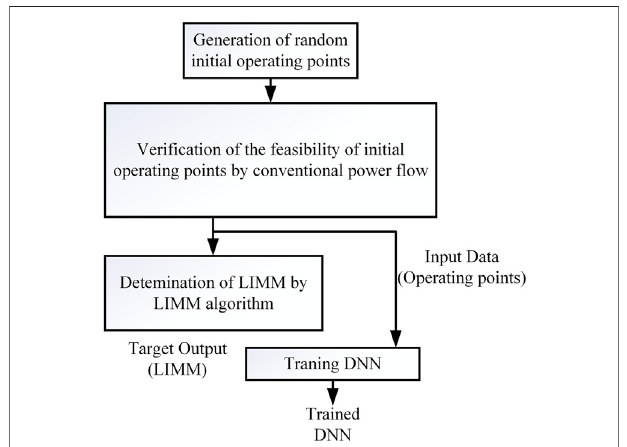
FIGURE 3 | DNN training process fl ow